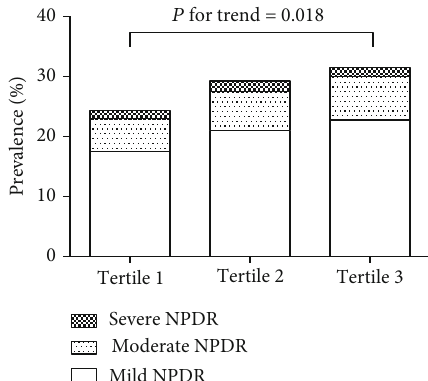
Figure. 2: Prevalence of diabetic retinopathy by tertiles of LH. The Cochran-Armitage trend test was used to analyze the di ff erence of incidence rate of diabetic retinopathy in di ff erent LH levels. With increasing levels of LH, there was a trend accompanied with higher prevalence of diabetic